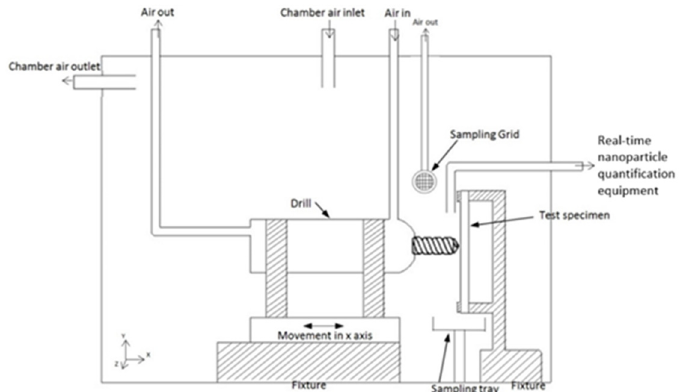
Figure 1. Design drawing of drilling setup within enclosed test chamber with cycled airflow to allow for a clean environment removing any background interference represented (not to scale).